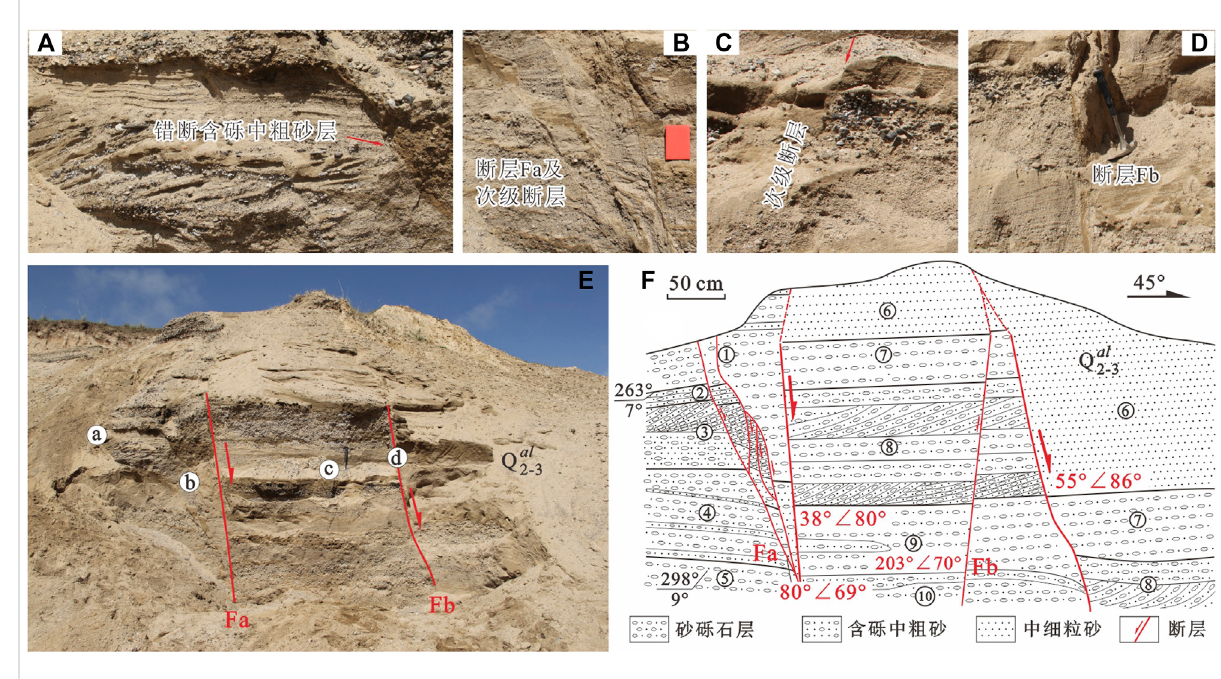
FIGURE 10 Stepped normal fault system west of the Rangdena sand mining fi eld